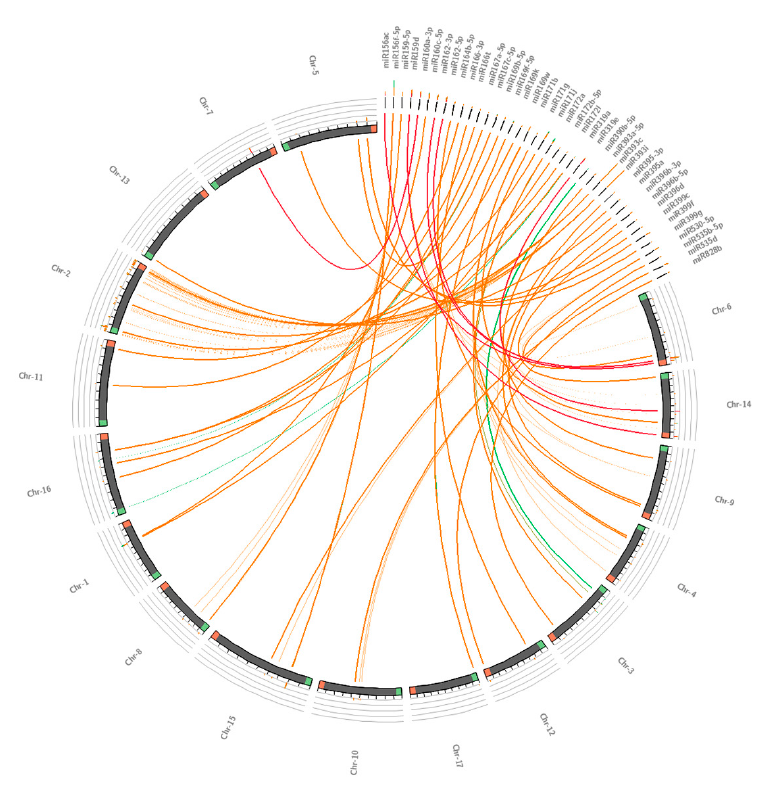
Figure 6. Comparative synteny map of potential guava miRNAs against the well-annotated genome of phylogenetically close species apple ( Malus domestica ).